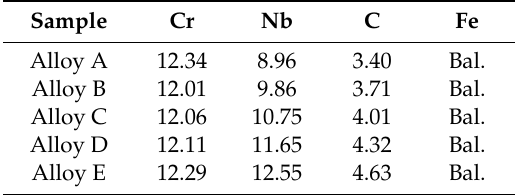
Table 1. Chemical composition (in wt.%) of various hardfacing coatings.